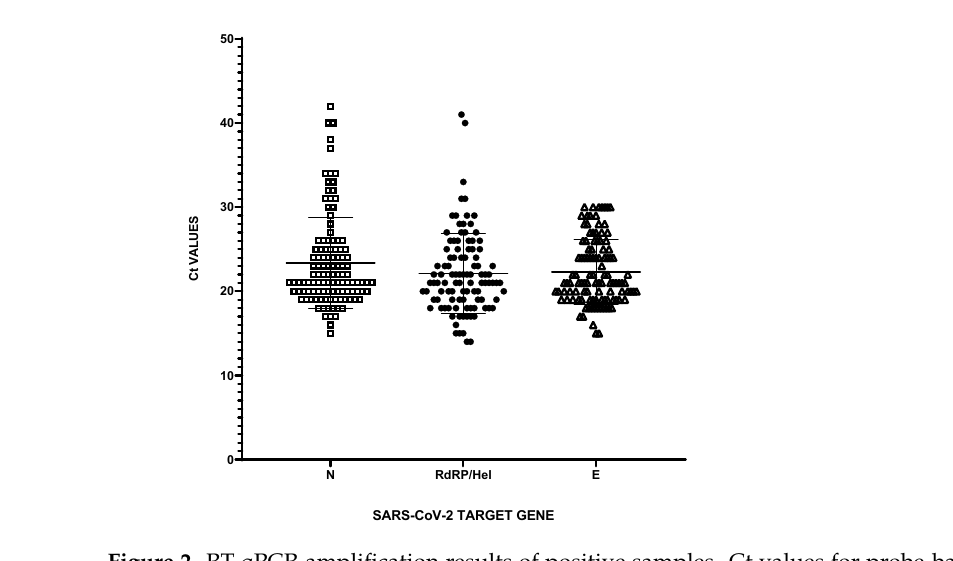
Figure 2. RT-qPCR amplification results of positive samples. Ct values for probe-based RT-qPCR amplification of N, RdRP/Hel and E genes in 115 SARS-CoV-2-positive samples. Out of the 115 positive samples diagnosed through RT-qPCR, the Ag-RDT detected 113 positive samples and 2 negatives (considered false negatives), whereas out of the 386 negative samples, the Ag-RDT detected 383 consistent samples and 3 false positives (Figure 3).